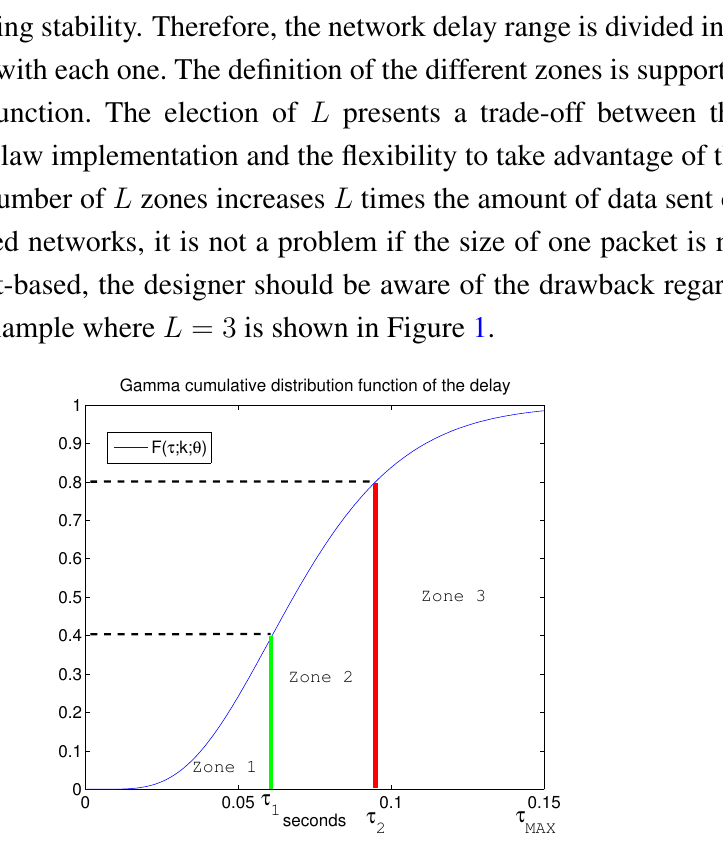
Figure 1. Gamma cumulative distribution function of the channel delay. Case study: L = 3